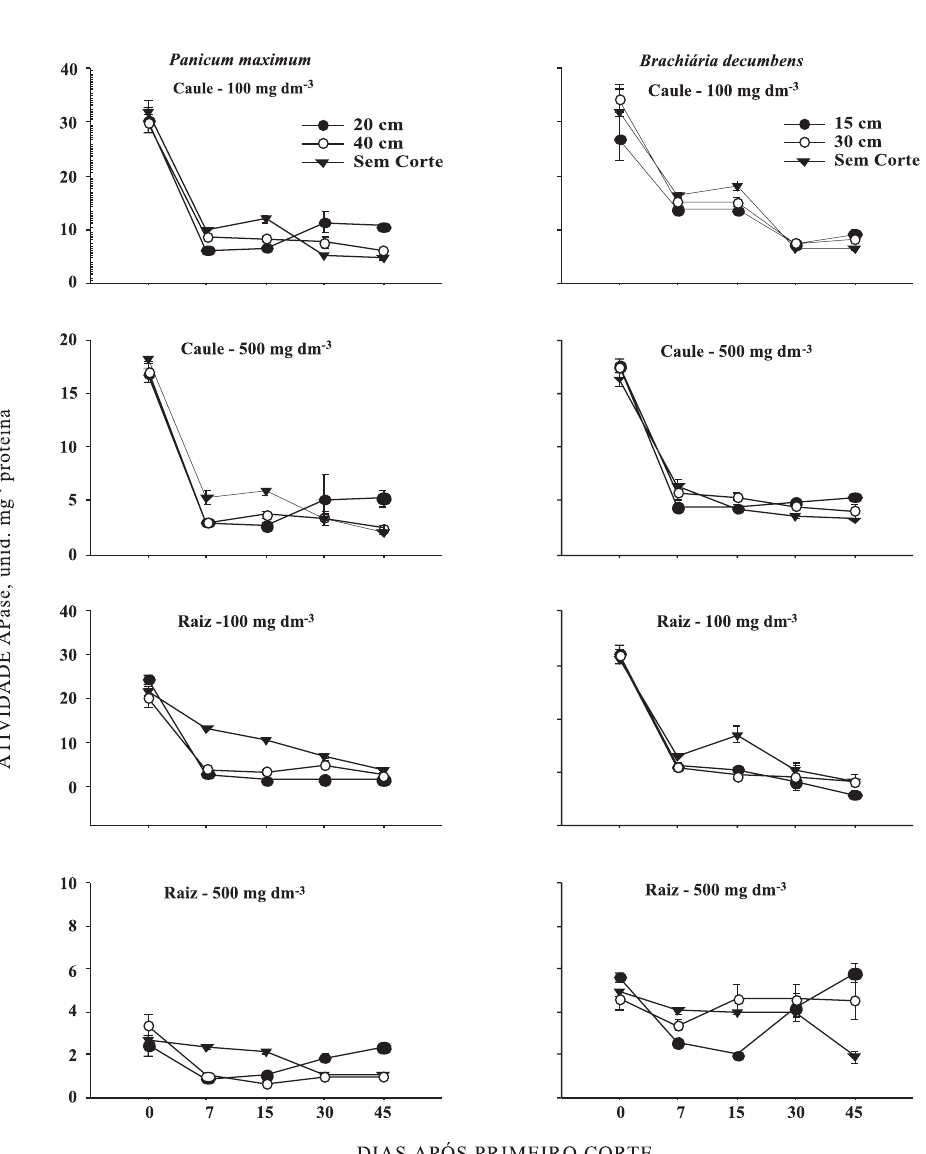
Figura 3. Atividade da fosfatase ácida (APase) no caule e raiz das forrageiras Panicum maximum e Brachiaria decumben s fertilizadas com 100 e 500 mg dm -3 de P e mantidas sem corte e com duas alturas de corte, em amostras coletadas aos 60 dias após o transplantio das plântulas, quando se realizou o primeiro corte (tempo zero), e depois, aos sete, 15, 30 e 45 dias. As linhas verticais representam os